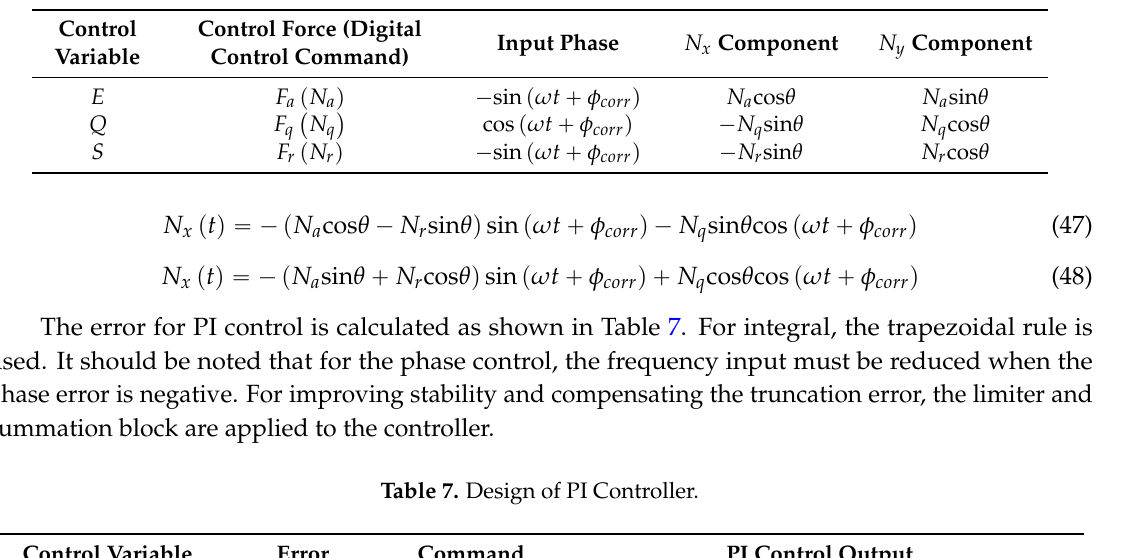
Figure 11. Components of the control forces in the orbit trajectory. Table 6. Components of the control forces.